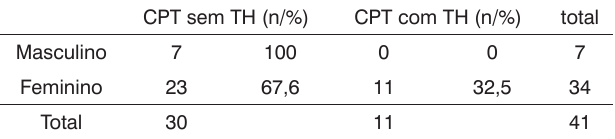
Tabela 2. Proporção entre gêneros e coexistência de CPT com